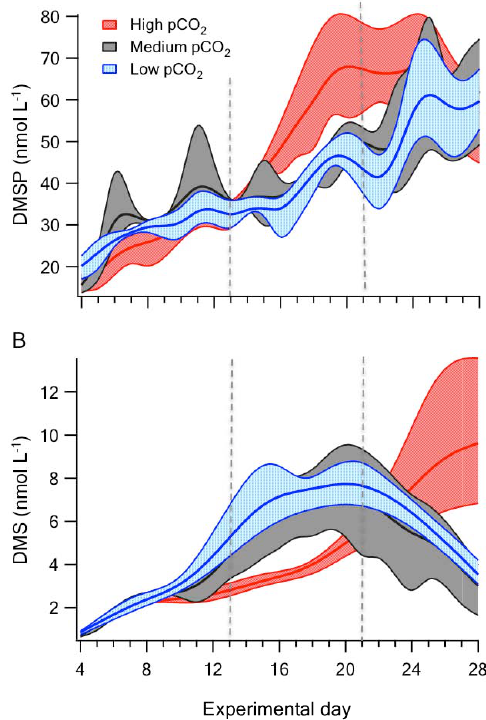
Table 1. Significance of the linear regressions between DMSPt